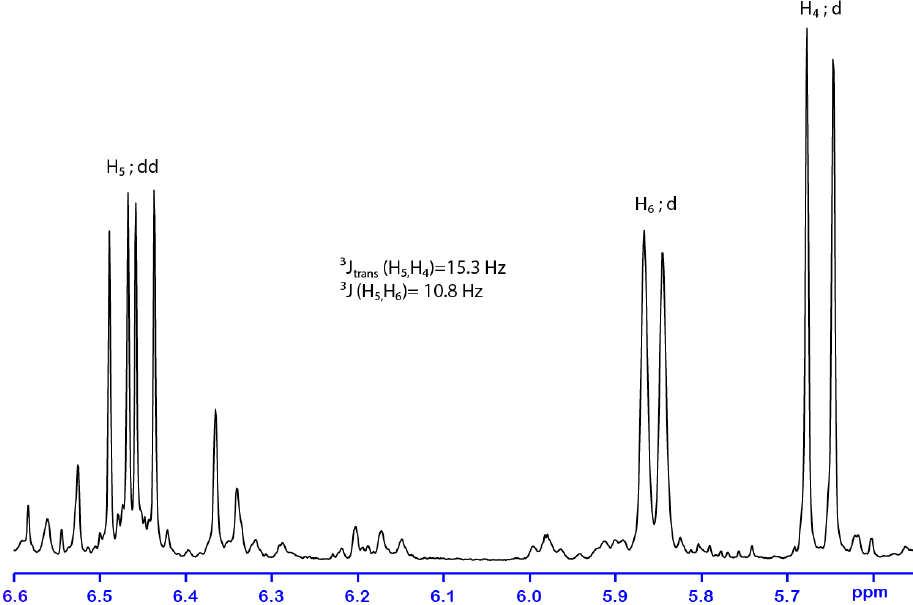
Figure 3. H-H coupling pattern of the ethylenic system of 58 .